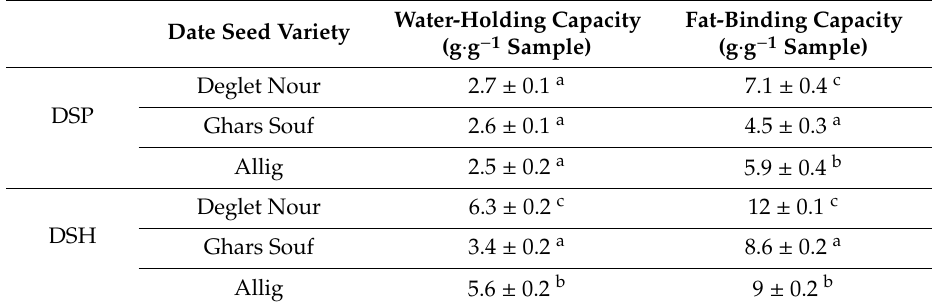
Table 2. The water-holding and fat-binding capacities of the three date seed varieties of Deglet Nour, Ghars Souf, and